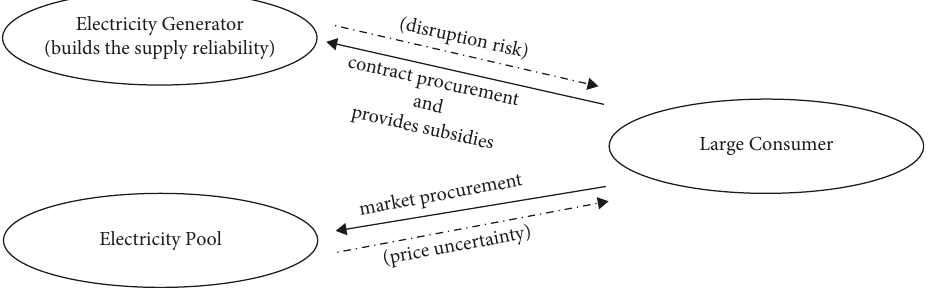
Figure 1: The electricity supply chain